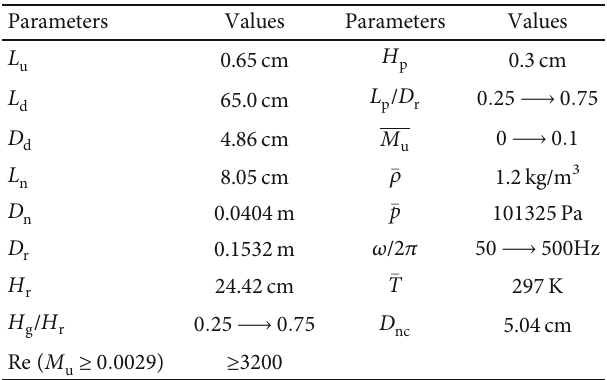
Table 1: Grazing fl ow, geometry, and physical sizes of the rectangular duct with the modi fi ed structured HR